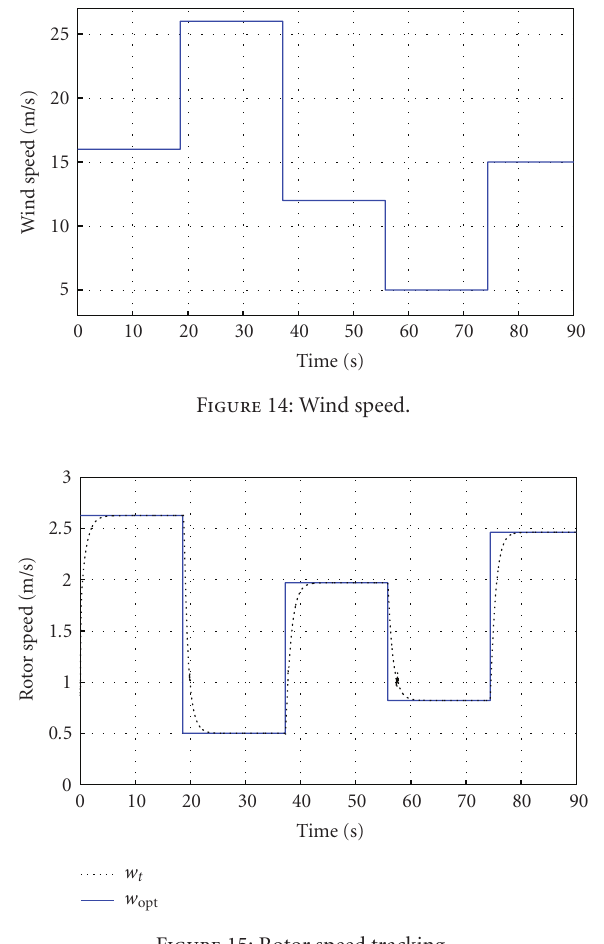
wave as shown in Figure 10. The rotor speed to capture the maximum power from the wind turbine is shown in Figure 11 (solid line). It is clear that the dotted curve in Figure 11 which represents the actual rotor speed coincides with the solid curve. As the wind speed ranges between the cut-in and rated speed of the wind turbine, the produced power curve takes almost the wind speed curve as shown in Figure 12. Figure 13 shows that the voltage profile is nearly constant and the voltage ripple is reduced to 90% compared with [15].